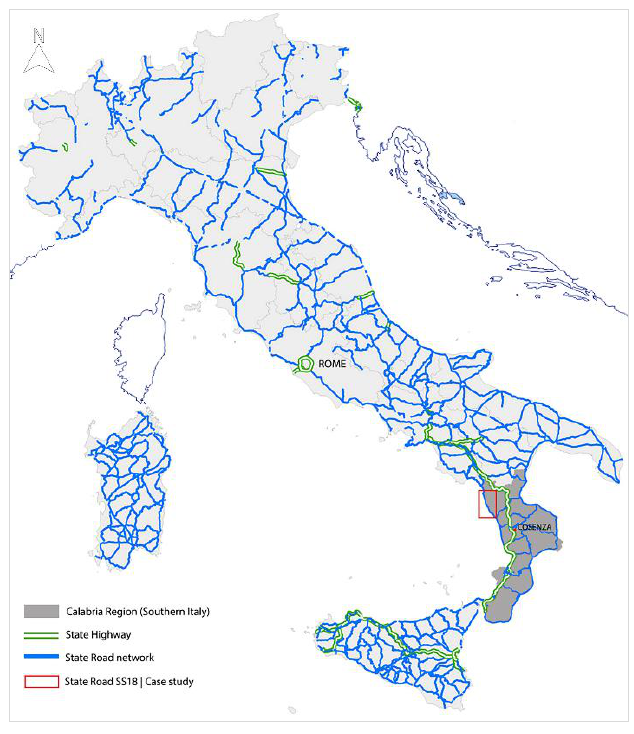
Figure 2. Test site localization. Table 2. Test site characterization.